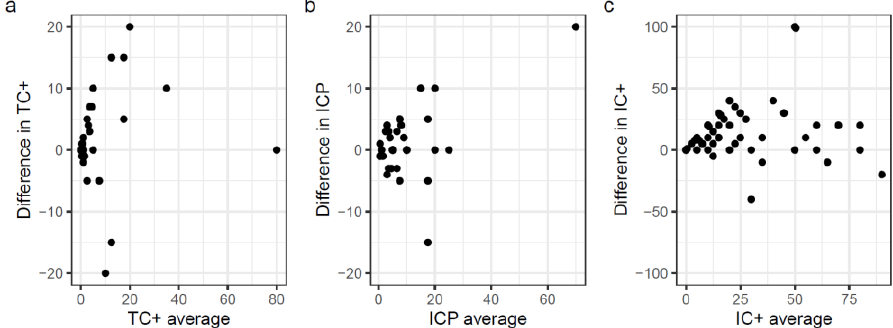
Figure 1. Bland – Altman plots for the three components scored. ( a ) TC+, ( b ) ICP and ( c )